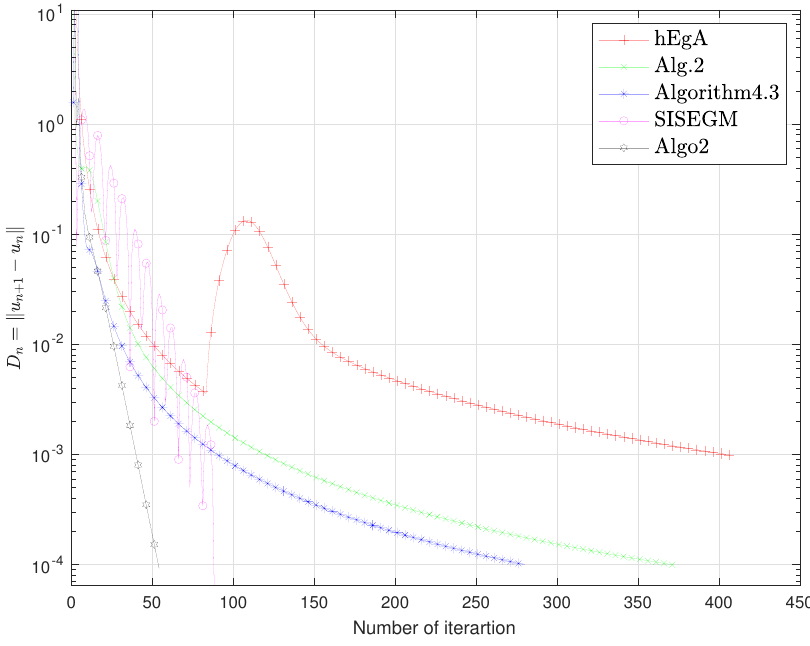
Figure 15. Example 3: Numbers of iterations are 406, 372, 280, 88, 54